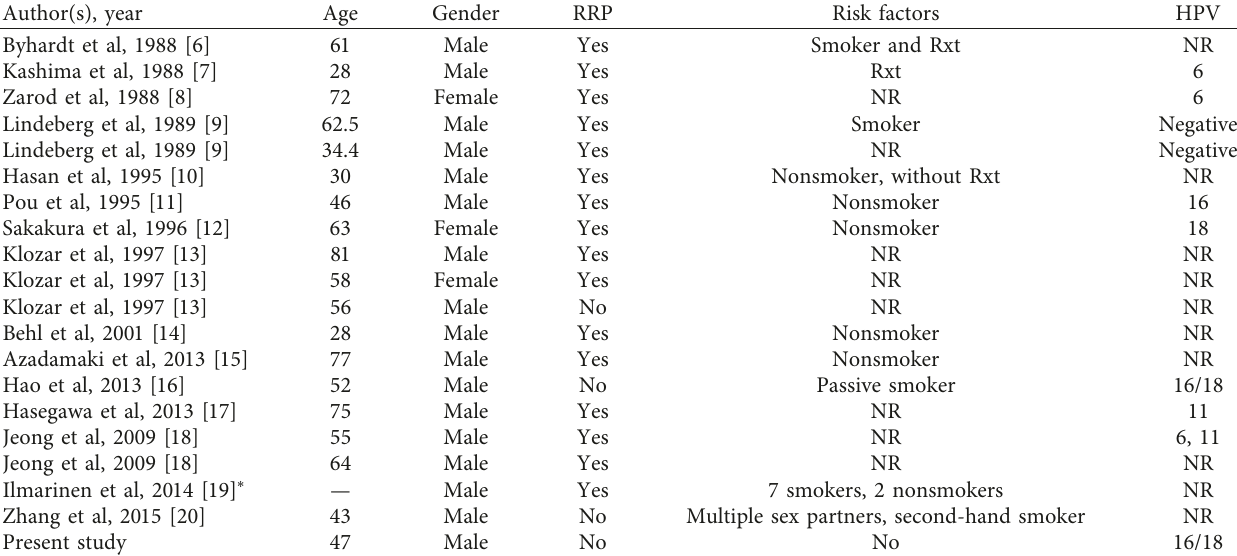
Table 1: Clinical information of adult patient’s onset who developed SCC and was reported in the English language literature. Author(s),